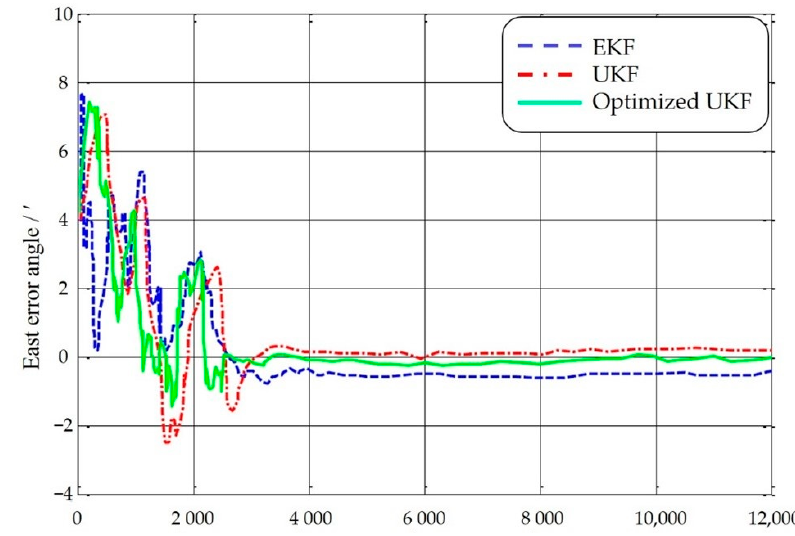
Figure 4. Filtering results of east error angle.